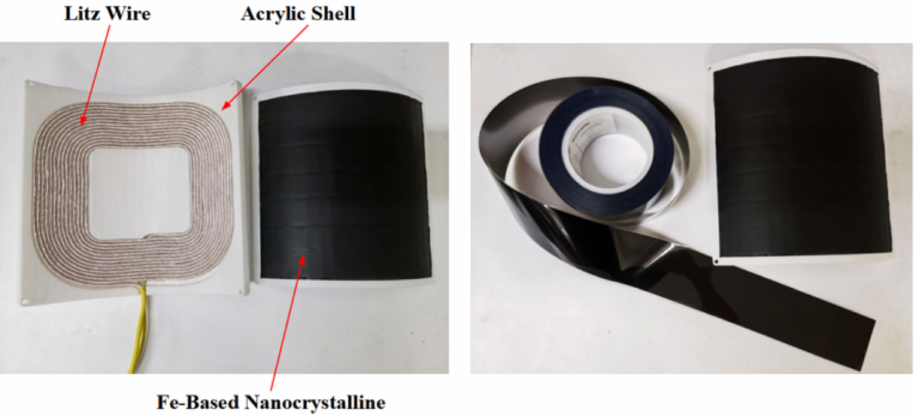
Figure 9. The UUV WPT magnetic coupler and its Fe-based nanocrystalline cores presented in